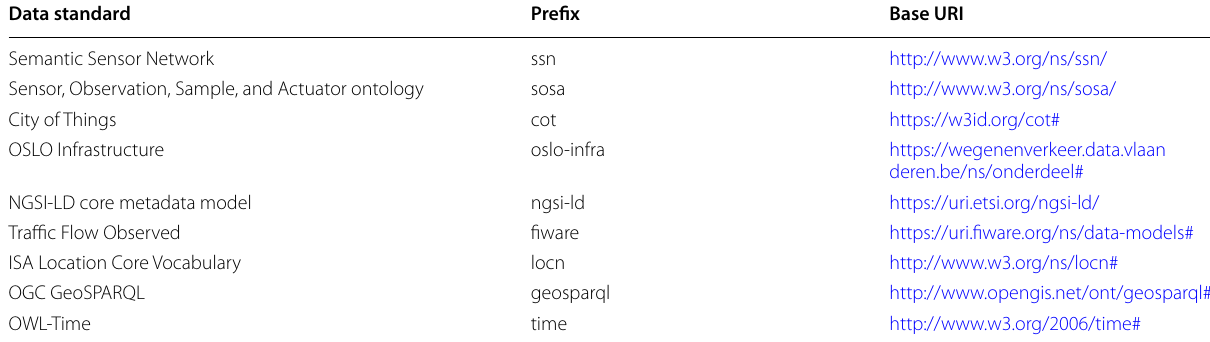
Table 3 The base URI of a data specification is shortened with a prefix Data